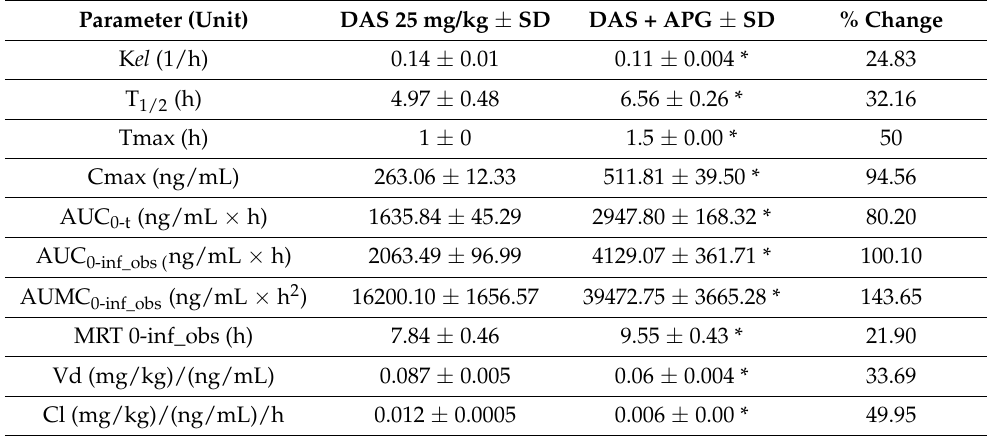
Table 1. Pharmacokinetic parameters (non-compartmental) of dasatinib along with apigenin follow- ing an oral administration in rats.